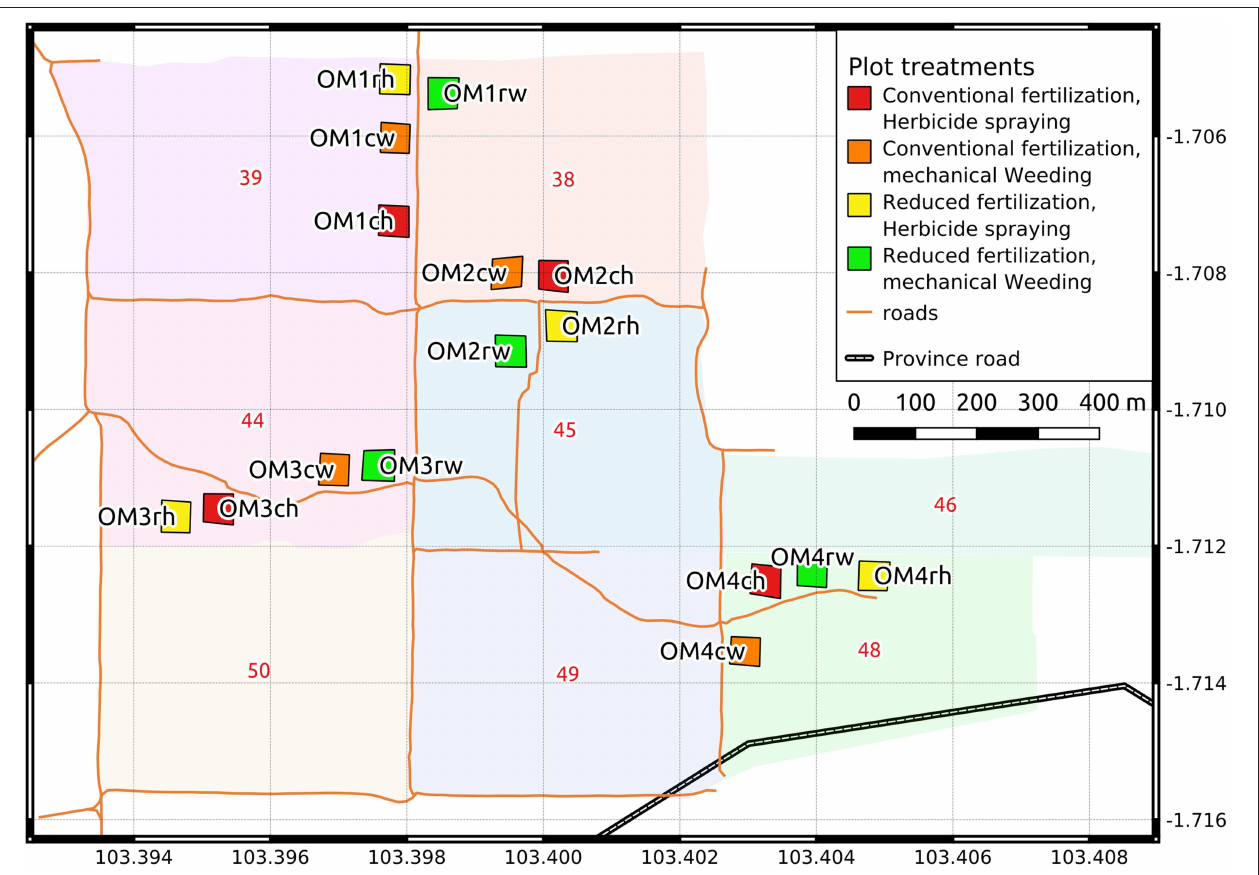
FIGURE 1 | Map of the 16 experimental plots, grouped in four sites. Plots are situated in different afdelings. Afdeling numbers are written in red and distinguished with different fill colors. Plot codes are written in black and indicate the following: “OM” stands for “Oil palm Management experiment”, sites are coded with numbers, treatments are coded with small letters. “c” corresponds to conventional, “r” to reduced fertilization. “h” corresponds to herbicide spraying, “w” to mechanical